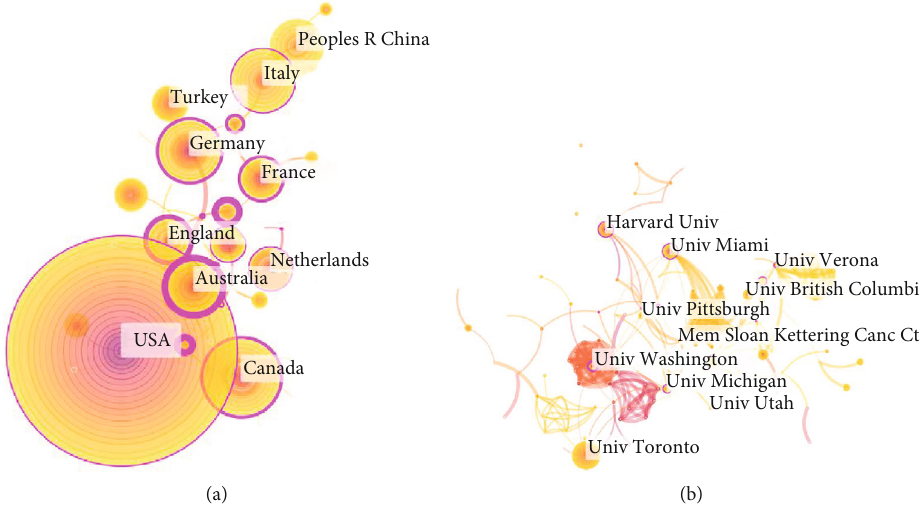
Figure 4: The analysis of countries and institutions. (a) Network map of countries/territories engaged in neuropathic pain rehabilitation research. (b) Network map of institutions engaged in neuropathic pain rehabilitation